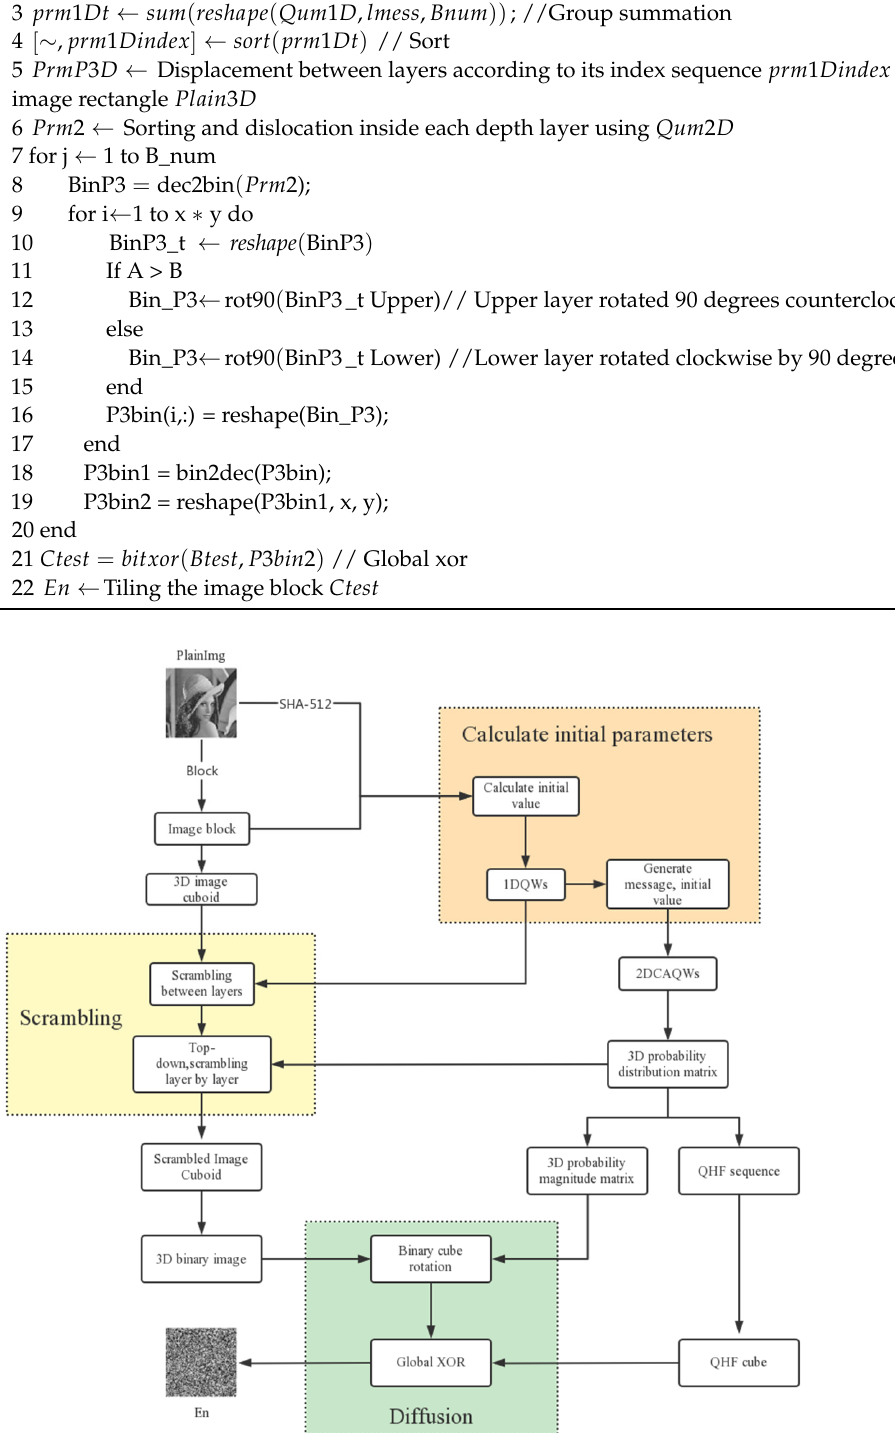
Figure 3. A 3D Cuboid Image Encryption Framework Based on Message-Encoded Controlled Alternate Quantum Walks. Algorithm 1. Sequence generation.